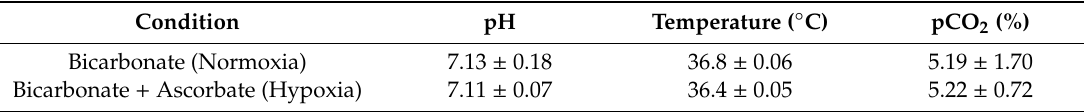
Table 1. The pH, temperature, and calculated pCO 2 levels inside the inner reservoir of cell culture devices incubated on-chip and jacketed with bicarbonate bu ff er with or without sodium